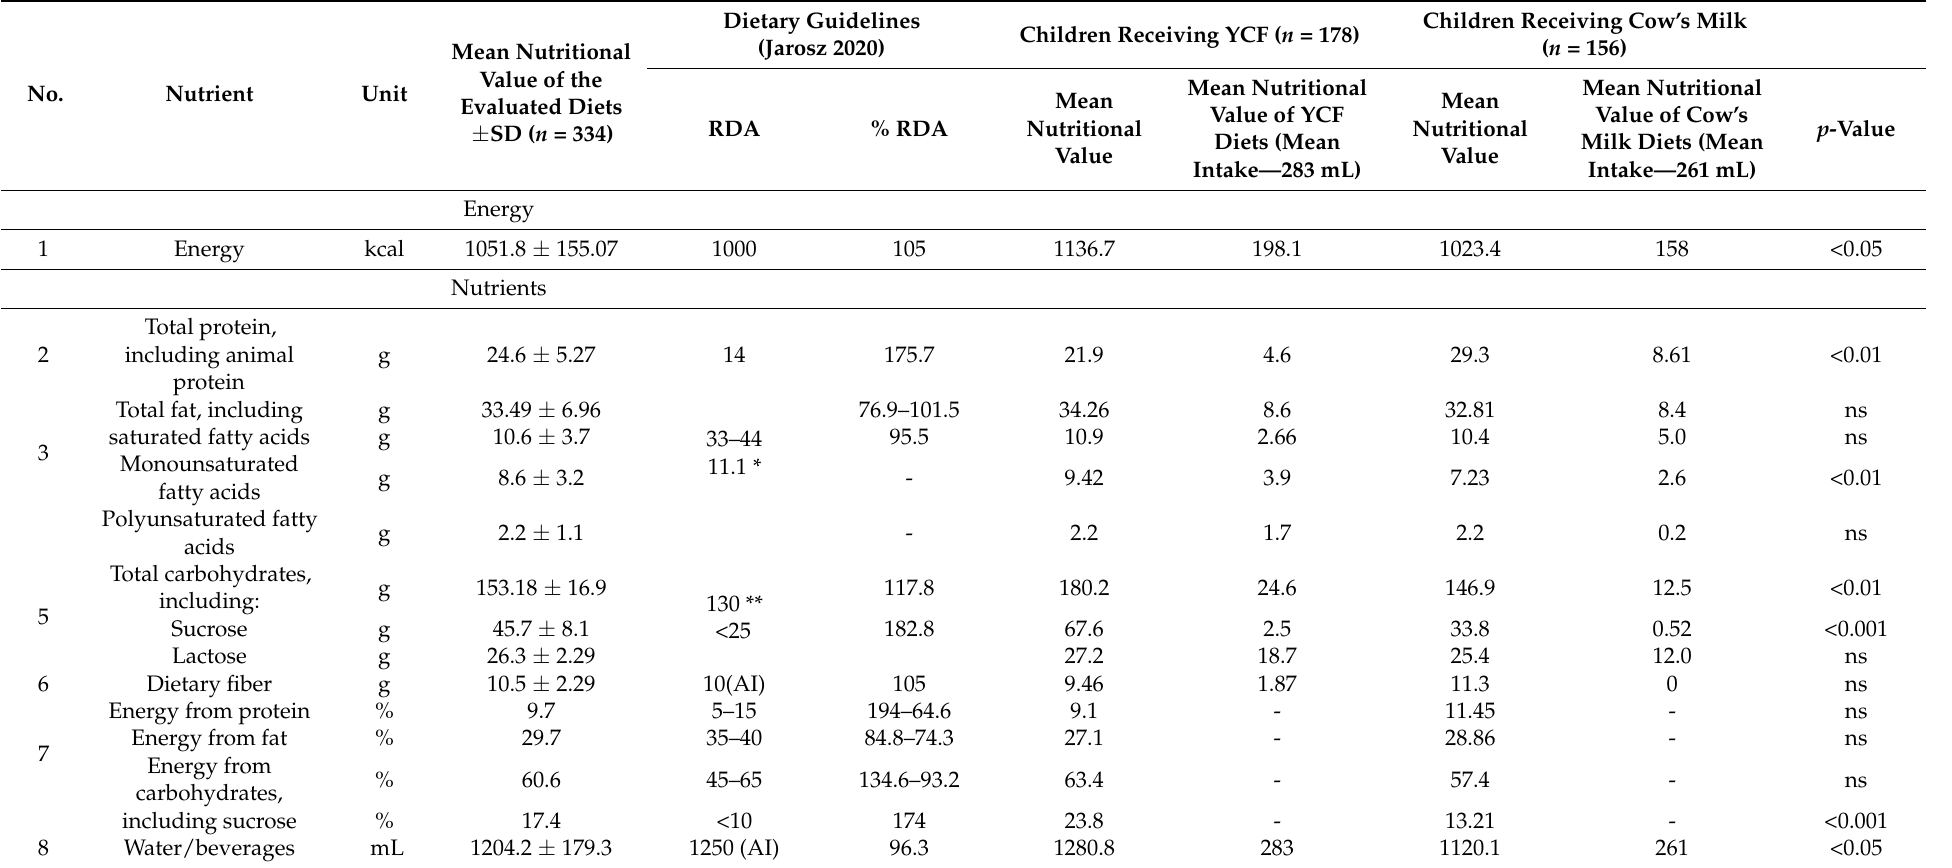
Table 4. Energy content nutritional value of the evaluated diets of children aged 13–24 months vs. dietary guidelines and expert